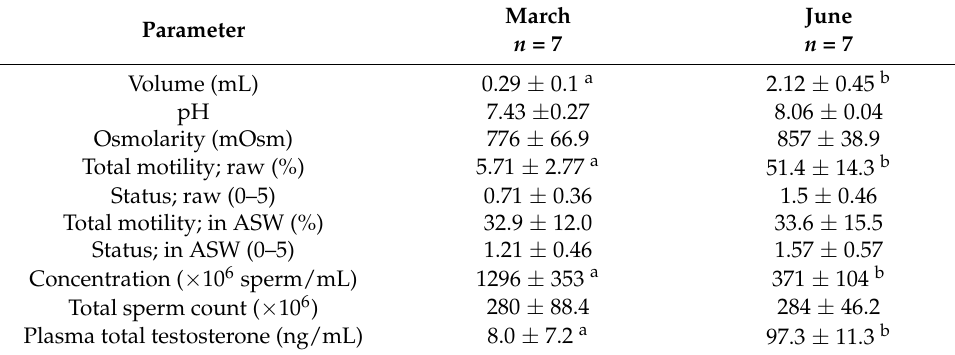
Table 1. Southern stingray ( Hypanus americaus ) ejaculate characteristics and plasma testosterone concentrations ( x ± SEM) by